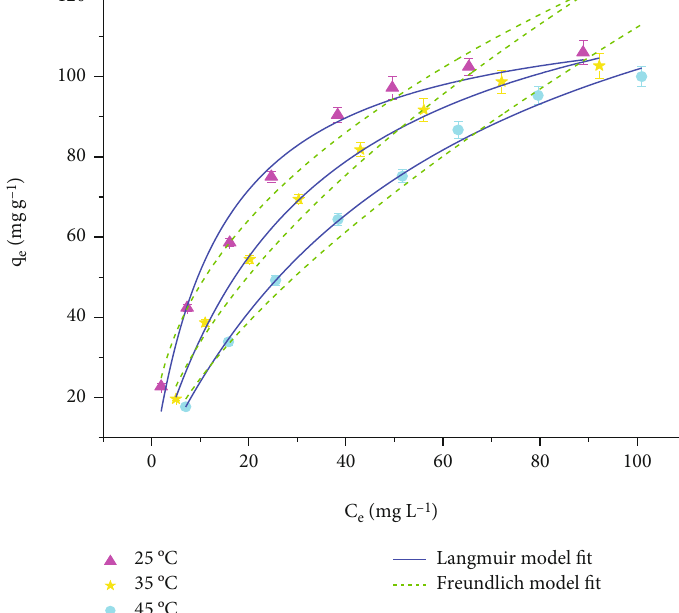
Figure 6: Adsorption equilibrium isotherms of BPA onto AgNP-SB- β CD